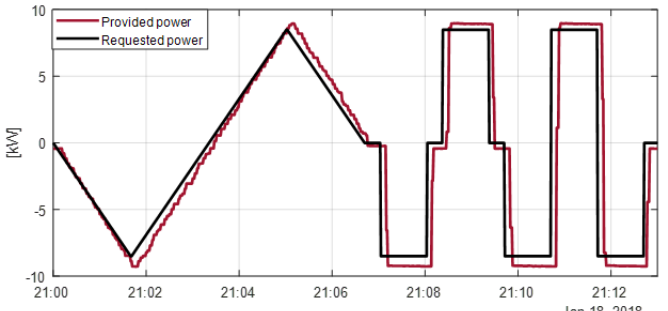
Figure 6. One cycle of the performed remote performance assessment